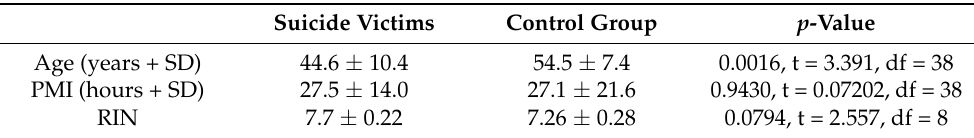
Table 1. Subject information and group comparison, including age, postmortem interval and RNA integrity number (mean ± SD).